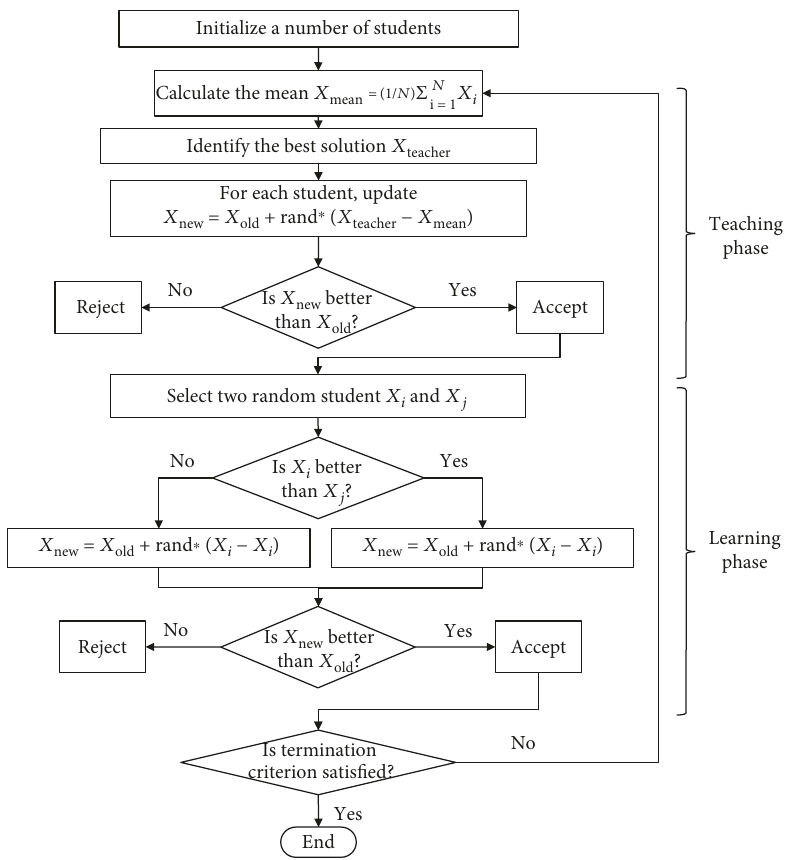
Figure 3: Typical framework of the